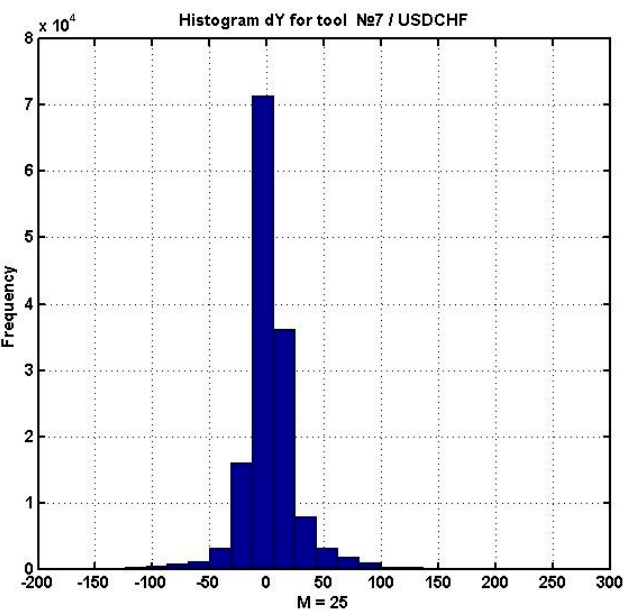
Figure 7. Process histogram 𝑑 (cid:3038) .